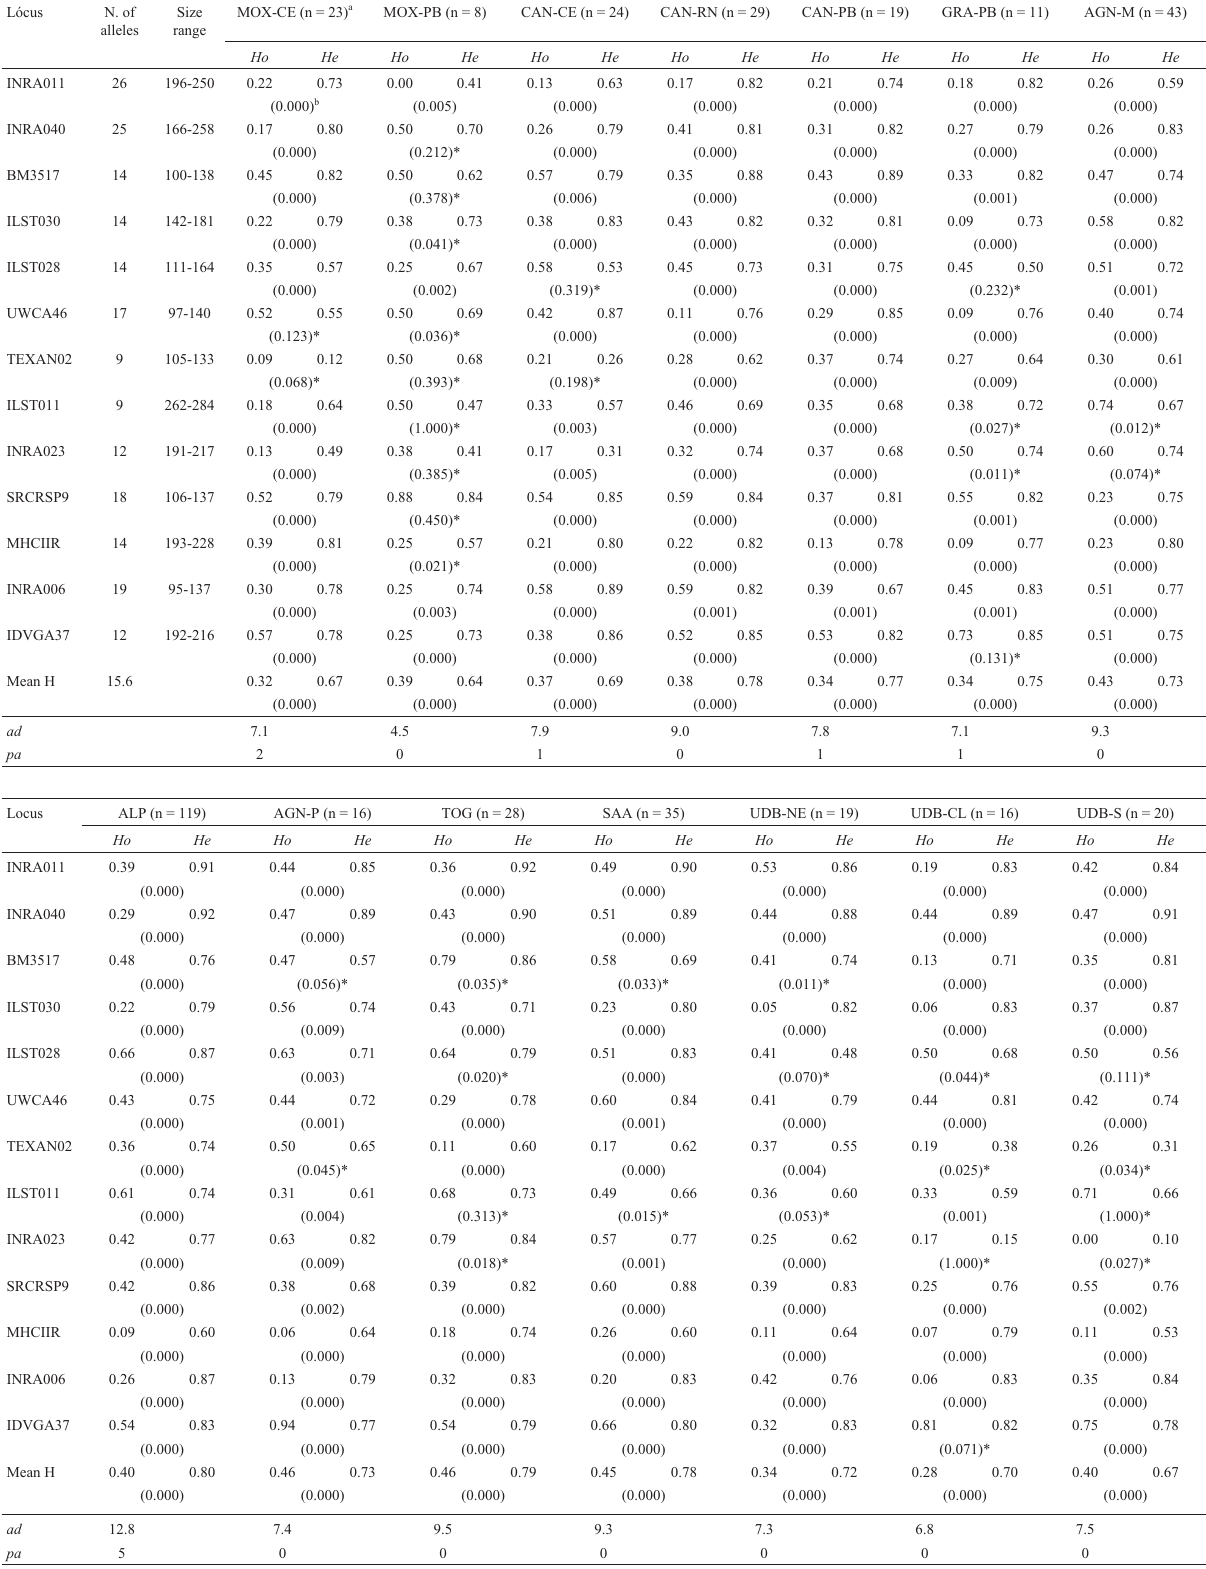
Table2 -Summaryofobserved( Ho ),expected( He ),mean( H )heterozygosity,allelicdiversity( ad )andnumberofprivatealleles( pa )overallgoatpopu- lations. At the single-population single-locus levels a total of 38 non-significant deviations from HWE were detected. Significant deviations from HWE were detected when either all populations or all loci were pooled (p < 0.001). * = no significant difference between H o e He (p > 0.01). Lócus N.of